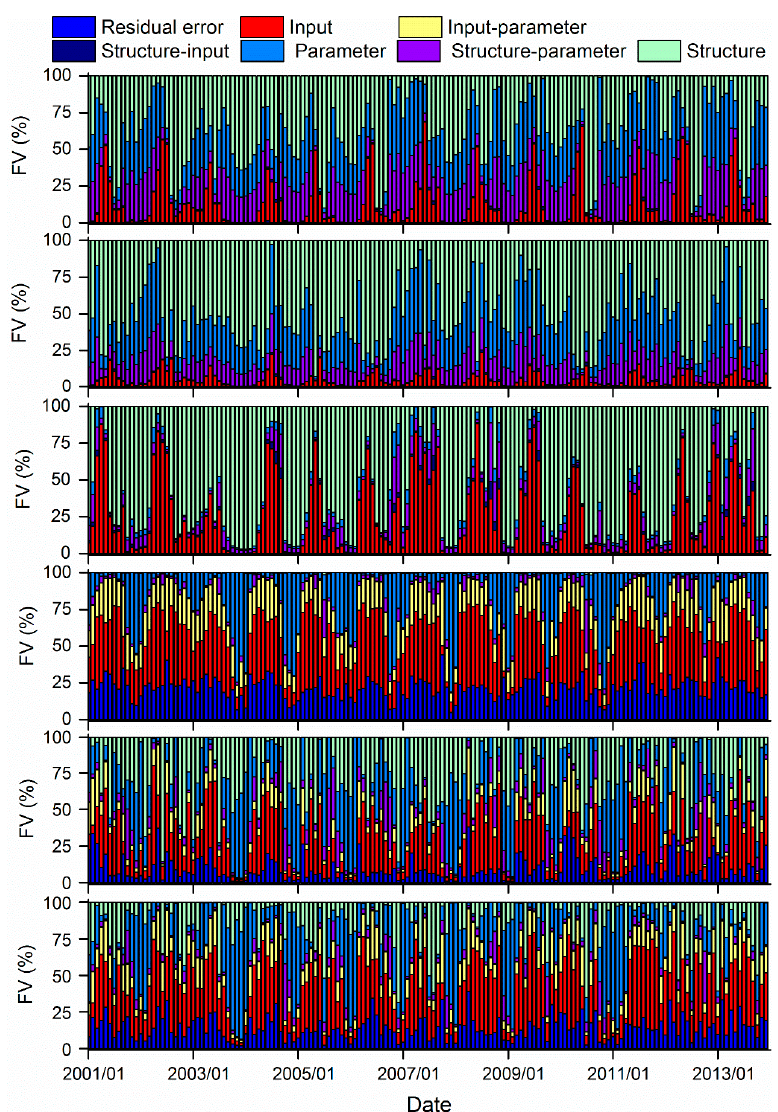
Figure 7. Fractional variances (FV) of seven uncertainty components for each of the combination schemes of two models and three precipitation input scenarios. The first three subplots represent the combinations of GR with gauge-based precipitation, 3B42RTv7 and 3B42v7 input; the fourth to sixth subplots represent the combinations of CREST with these three inputs.